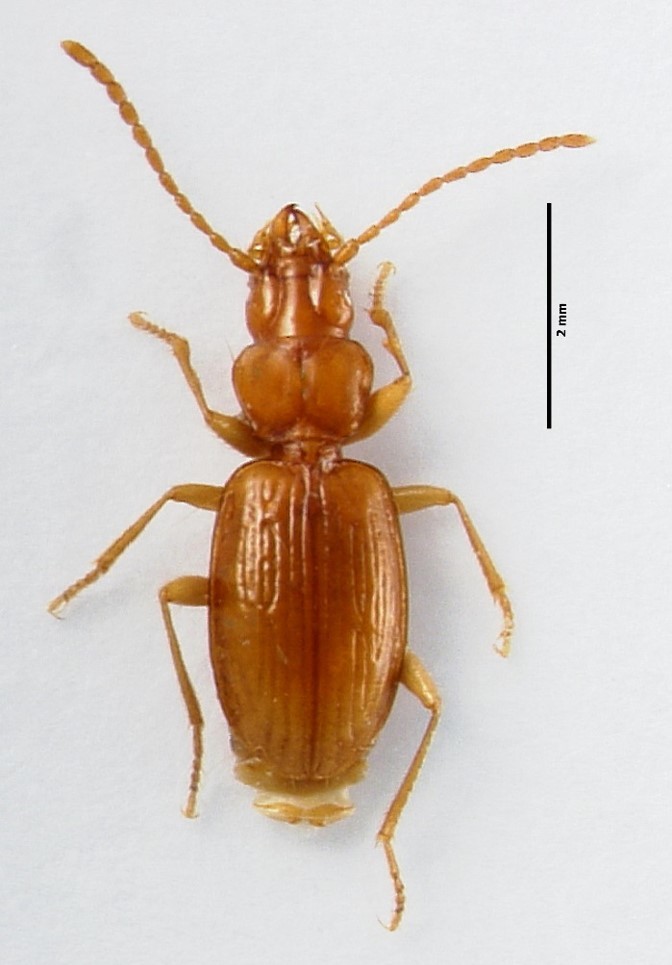
Thalassophilus
azoricus (Oromí & Borges, 1991) from São Miguel island (Azores, Portugal) (Credit: Enésima Mendonça, Azorean Biodiversity Group, cE3c).